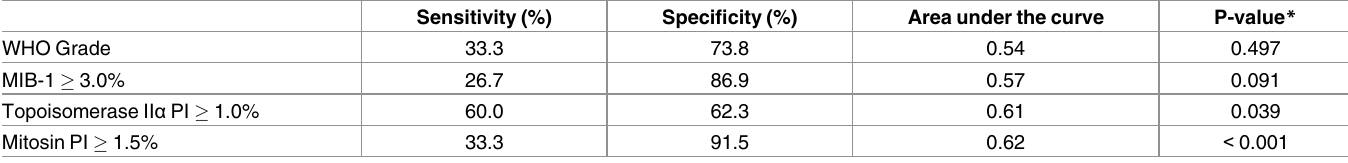
Table 3. Receiveroperator characteristics (ROC) analysesof cutoff